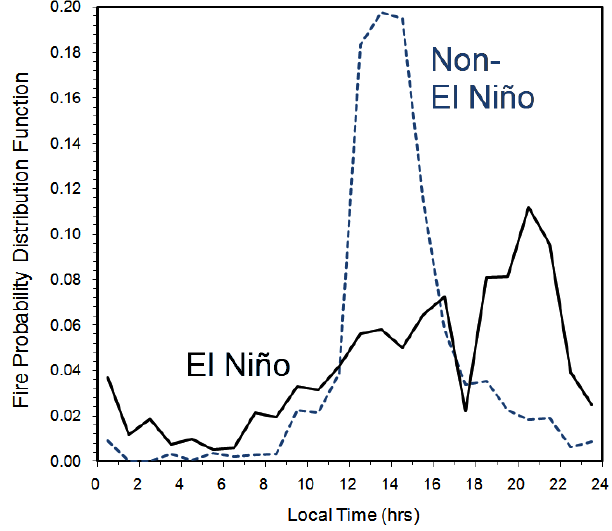
Fig. 5. Fire diurnal cycle in Borneo during El Ni˜no and non-El Ni˜no periods, as derived from TRMM VIRS active fire data (Giglio, 2007). During non-El Ni˜no periods (1999–2001), the majority of fire activity is centred on a relatively short period between noon and 16:00hr LT, while during an El Ni˜no period (1998) the fire diurnal cycle appears significantly damped, with the peak shifted towards early night-time ( ∼